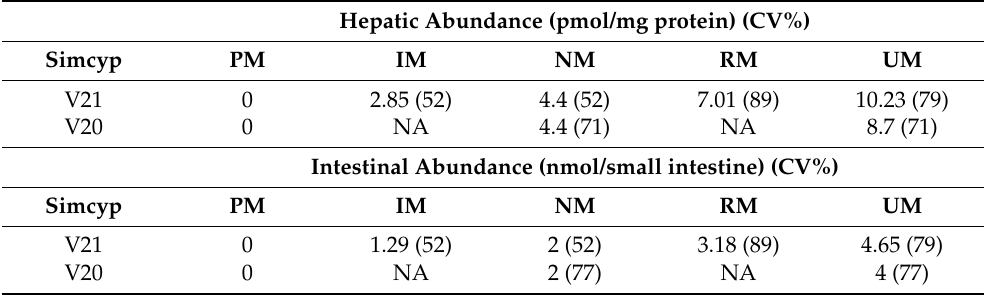
Table 1. Updated Hepatic and Intestinal CYP2C19 Enzyme Abundance Implemented in the Simcyp Simulator v21 Compared to